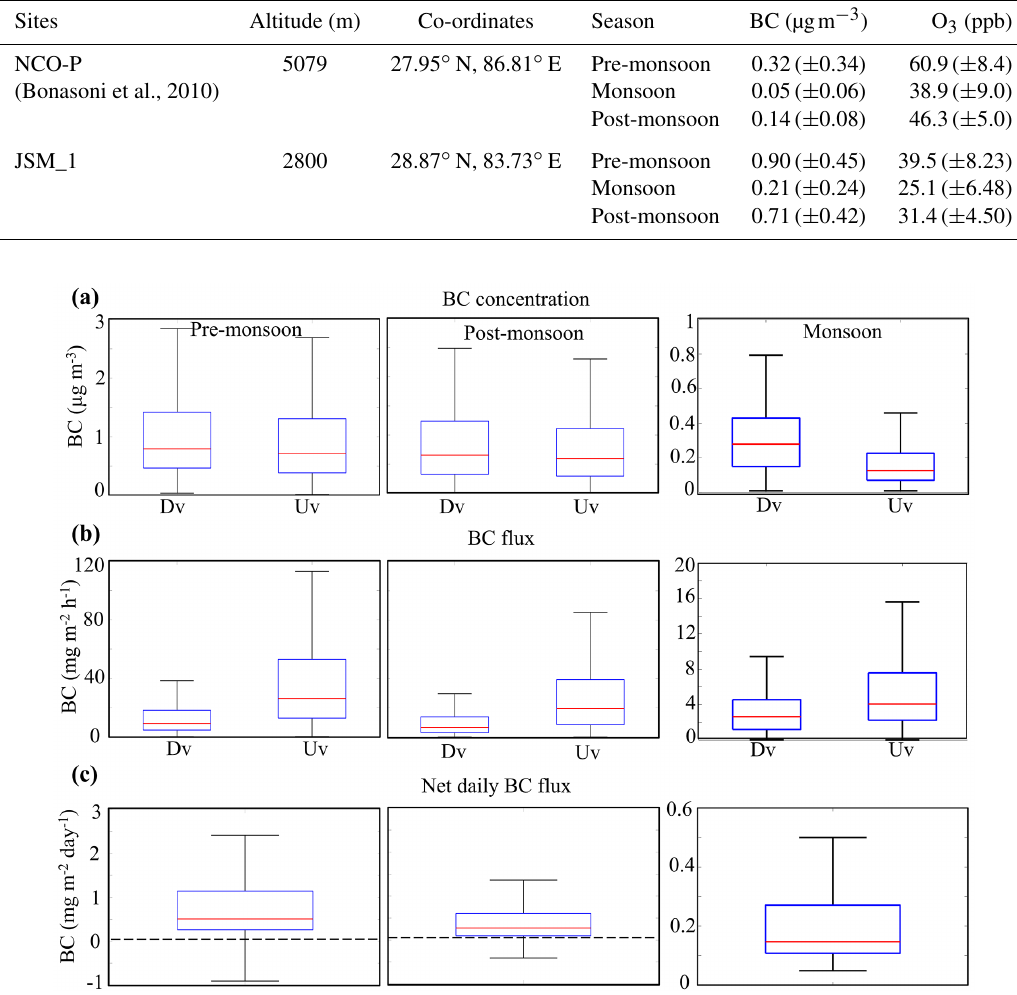
Figure 7. (a) BC concentration distribution with down-valley (Dv) and up-valley (Uv) flows in Jomsom, (b) calculated Dv and Uv flux for each season, (c) net daily flux per season. The dotted line in (c) marks 0mgm − 2 day − 1 (pre- and post-monsoon are from − 1